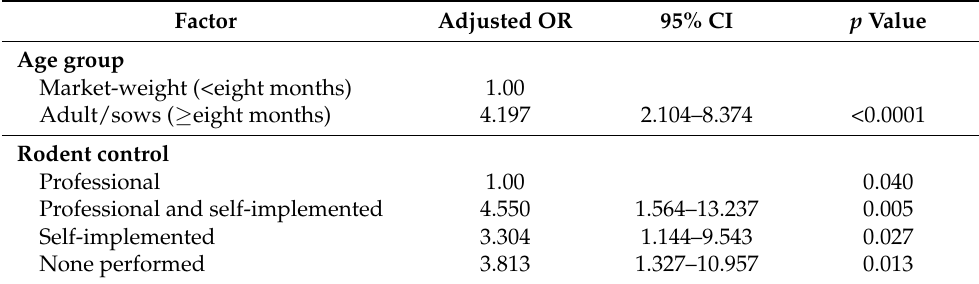
Table 2. Risk factors for Toxoplasma gondii infection in all sampled pigs (N = 825) in Serbia. Final multivariate model; individual pigs as units of analysis.